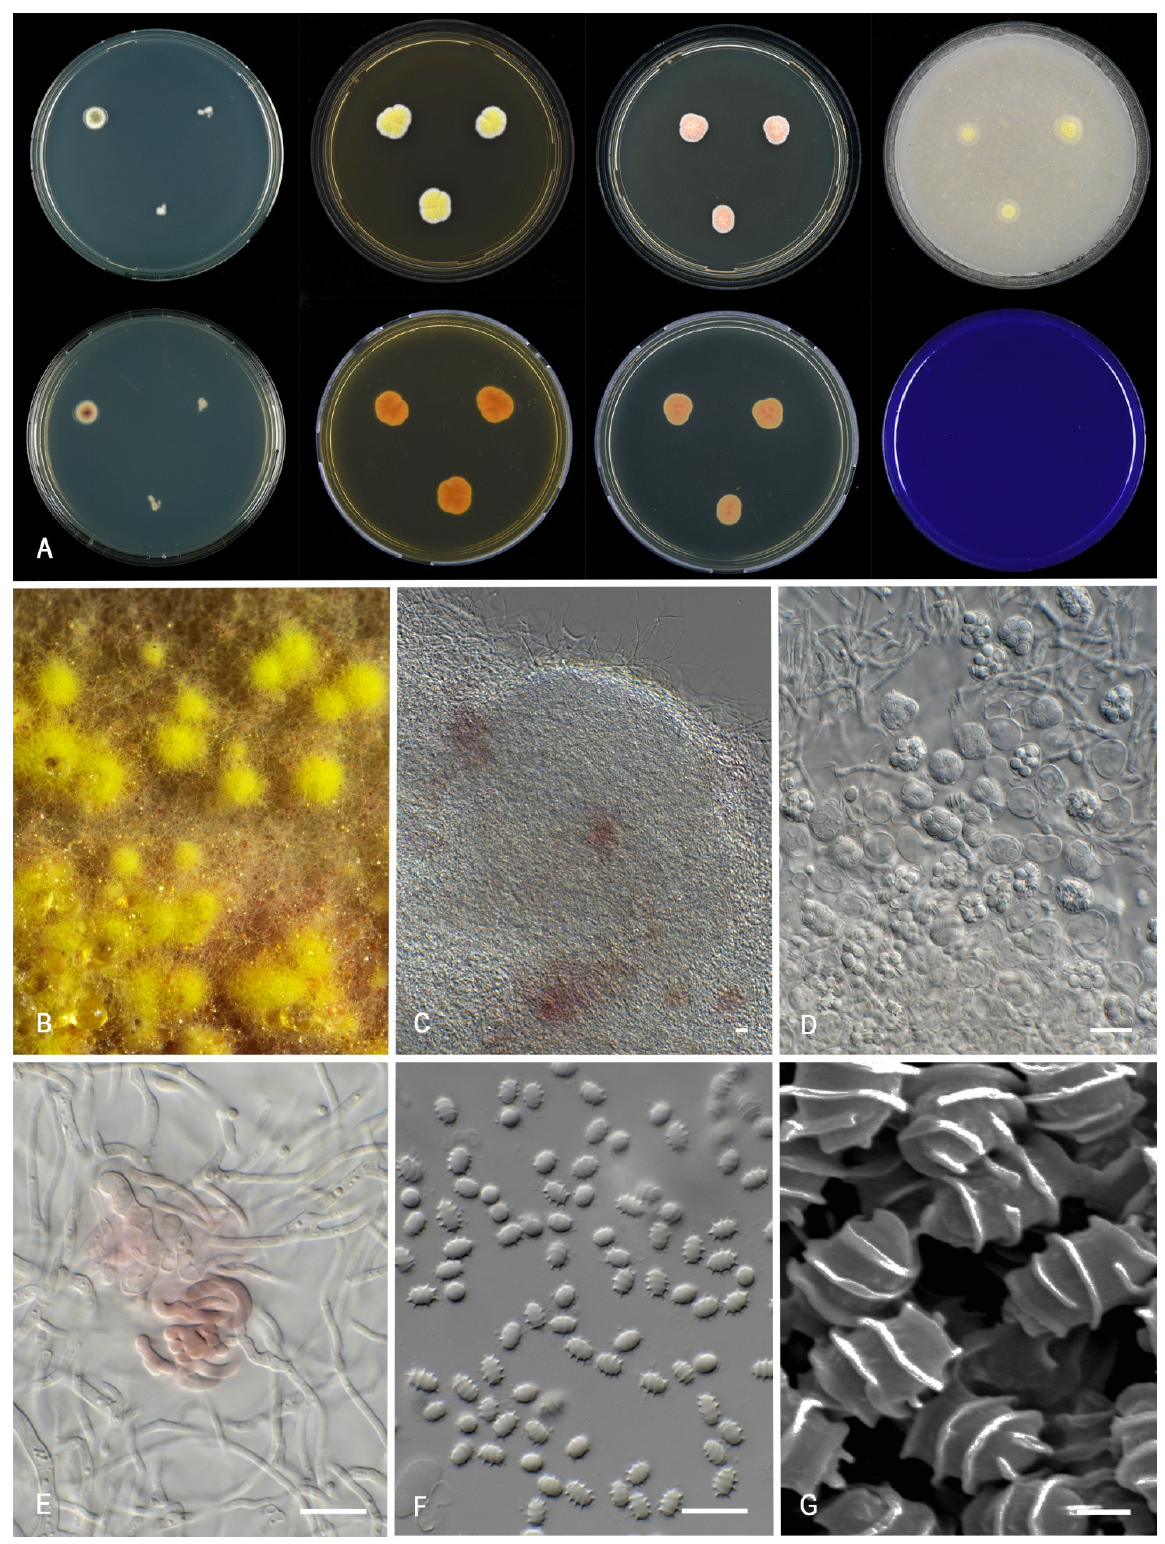
Figure 13. Morphological characters of Talaromyces udagawae (CBS 579.72). ( A ). Colonies, from left to right, after 7 d at 25 °C (top row) CYA, MEA, YES, OA; (bottom row) CYA reverse, MEA reverse, YES reverse, CREA. ( B ). Detail of colony on MEA. ( C ). Ascoma. ( D ). Asci and ascospores. ( E ). Initial. ( F , G ). Ascospores. Scale bars = 10 μ m; except ( G ), 1 μ m.